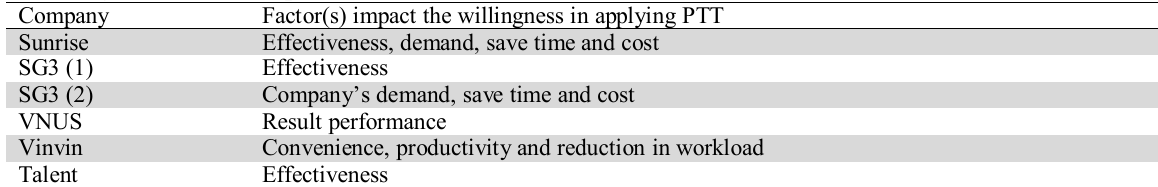
Summary of factor(s) impact